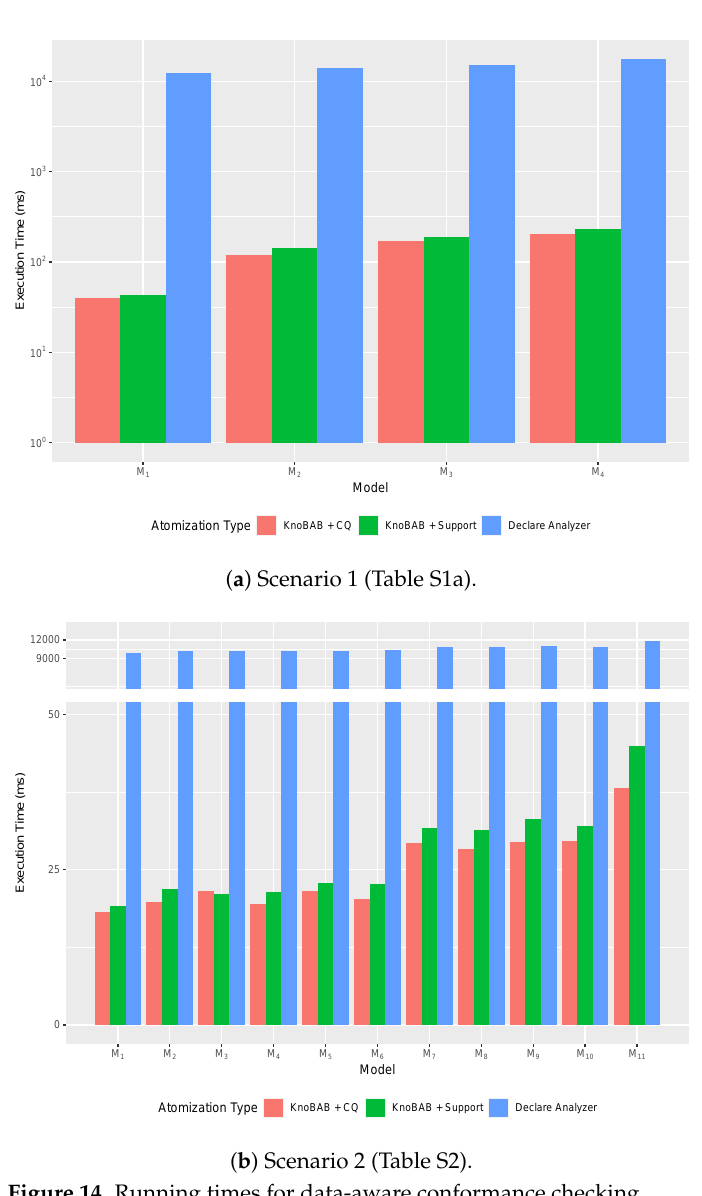
Figure 14. Running times for data-aware conformance